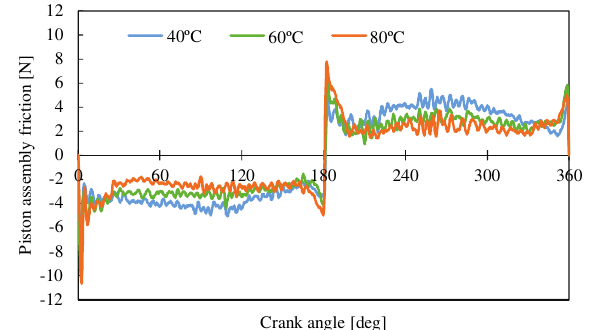
Fig. 6. Effect of temperature on piston assembly friction with three-ring set at 1000 rpm